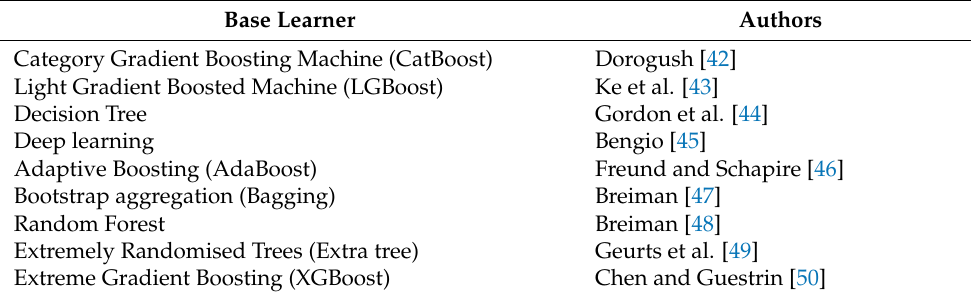
Table 4. Summary of algorithms used as base learners and corresponding authors. Base Learner Authors Category Gradient Boosting Machine (CatBoost) Dorogush [42] Light Gradient Boosted Machine (LGBoost) Ke et al. [43] Decision Tree Gordon et al. [44] Deep learning Adaptive Boosting